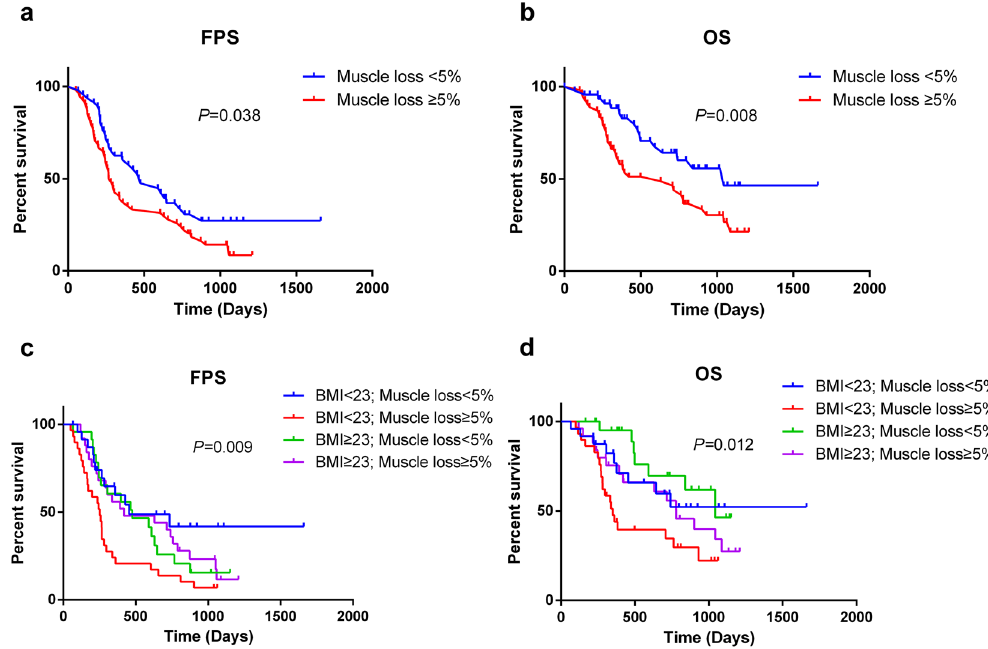
Figure 4. Kaplan-Meier curves for comparison of survival between patients with muscle loss (muscle loss ≥ 5%)and those with stable muscle (muscle loss < 5%). ( a ) Progression free survival (log-rank P = 0.038). ( b ) Overall survival (log-rank P = 0.008). Adding BMI to separate the patients into 4 goups. ( c ) Progression free survival (log-rank P = 0.009). ( d ) Overall survival (log-rank P =